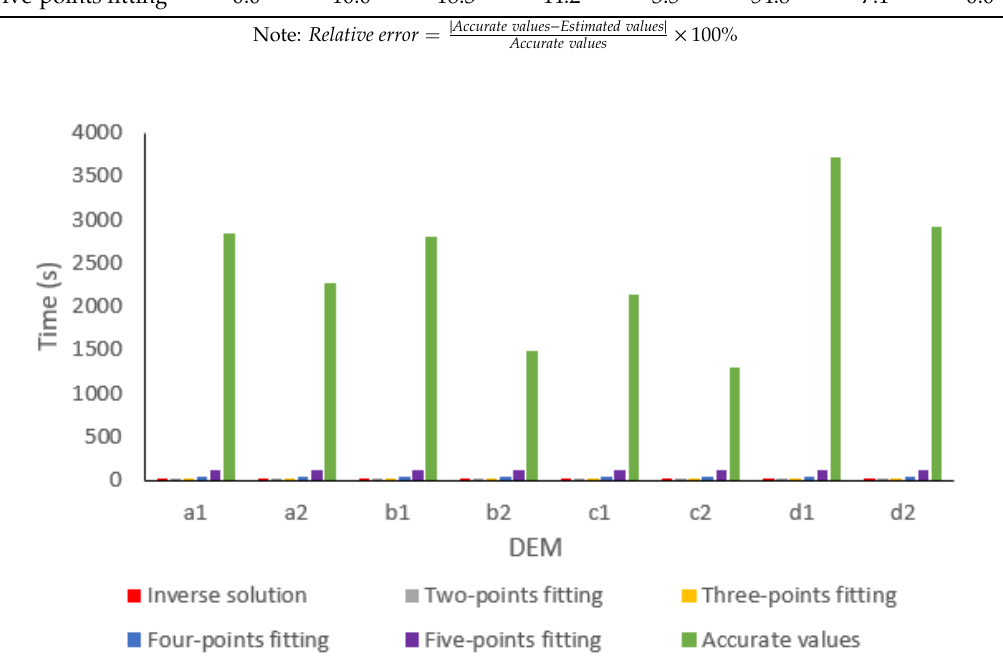
Figure 8. A comparison of the computation time required for four pairs of DEMs from accurate values and estimates produced by five methods. Table 4. The computation times (s) of the absolute Boltzmann entropy calculated using di ff erent methods for eight DEMs.